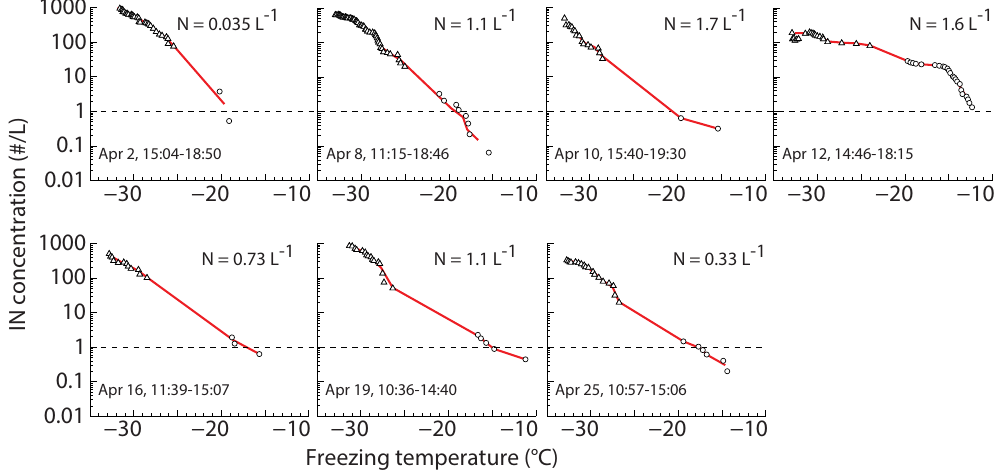
Figure 8. Summary of ambient air ice nuclei data during the April pollen season. Number of IN per litre of air is obtained from the SAC. The label in the bottom left of each plot indicates the date and time the sample was collected. The N value in the top right corner denotes the average number of pollen grains per litre of air during the closest 24h period during which the NC Department of Air Quality pollen counts coincided with sample collection. The symbols corresponding to picodrops and nanodrops are identical to those in Fig. 3. The red lines are the 1 ◦ averages of the IN concentrations. The horizontal dashed line corresponds to IN concentrations of 1L − 1 and is added to guide the